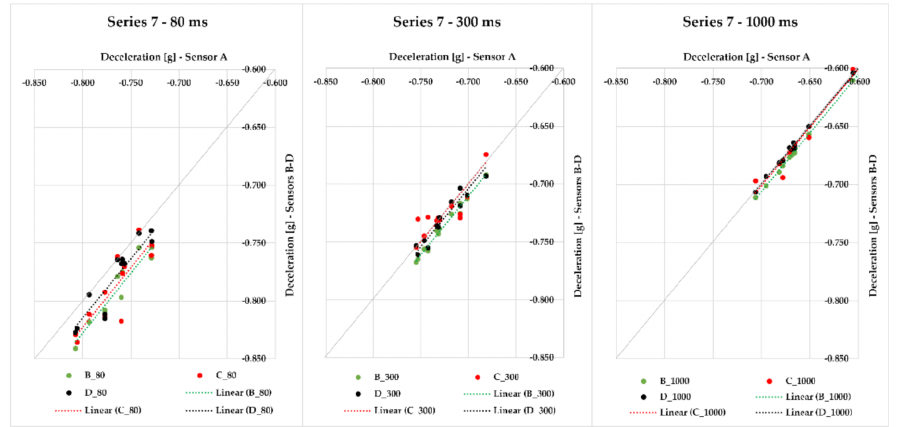
Figure 13. Series 7-Point dependency of individual MEMS sensors against sensor A.